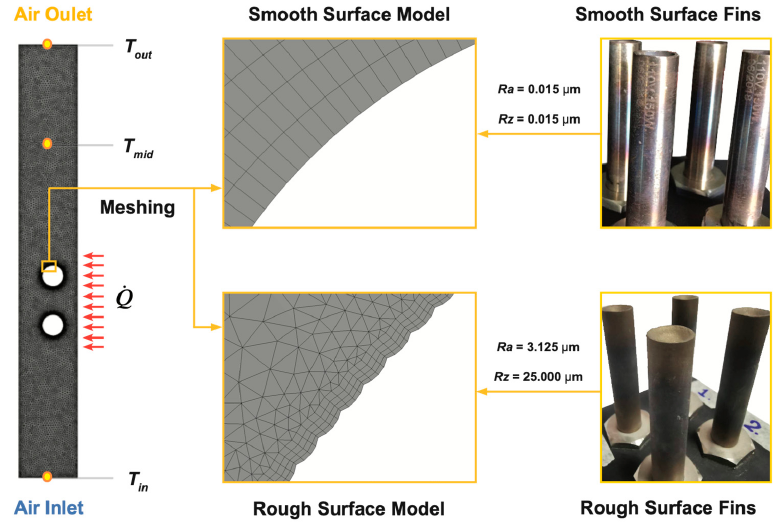
Figure 3. The simulated surfaces and meshing of the smooth fins and shot peened fins.